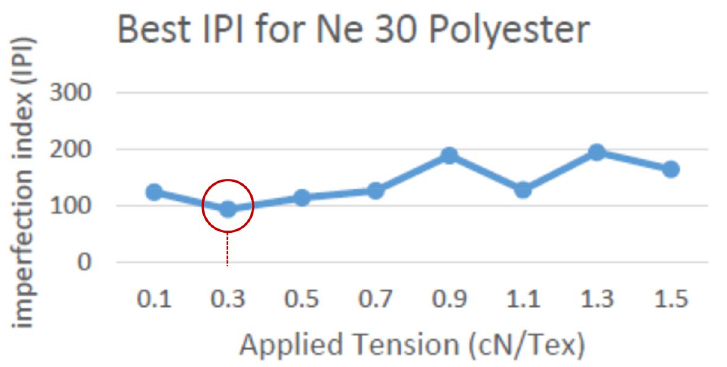
Figure 15. Best IPI for yarn count Ne 30 polyester